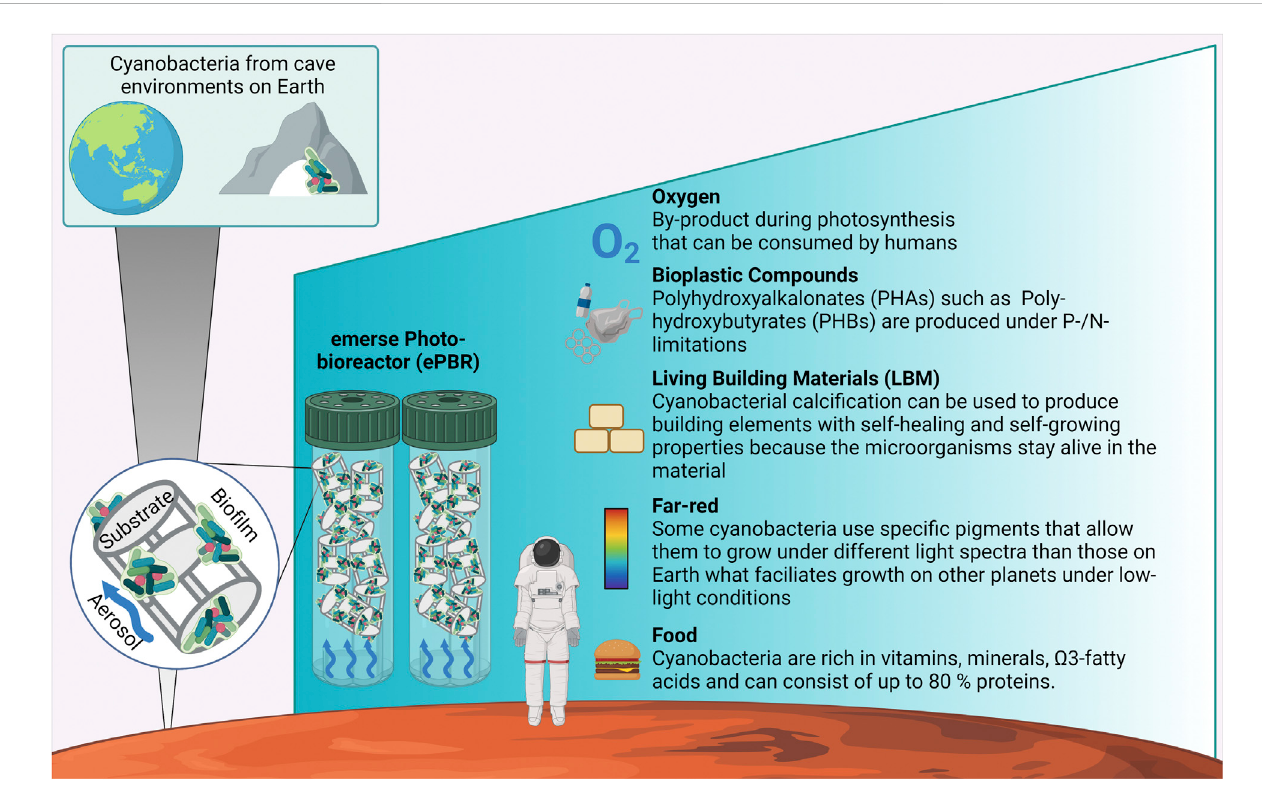
Potential of cave-inhabiting cyanobacteria as a model for astrobiology. Cyanobacteria from caves on Earth possess unique properties that make them great candidates for biotechnological applications during human colonization of other planets or the Earth ’ s Moon. Using minimum resources they can be growninemersephoto-bioreactors(ePBR)thatproduceanaerosoldirectedoversurfacesofbiocarriersonwhichthecyanobacterialbio fi lmestablishes.This technique allows the manufacturing of important and yet in this context ignored products such as living building materials or bioplastic